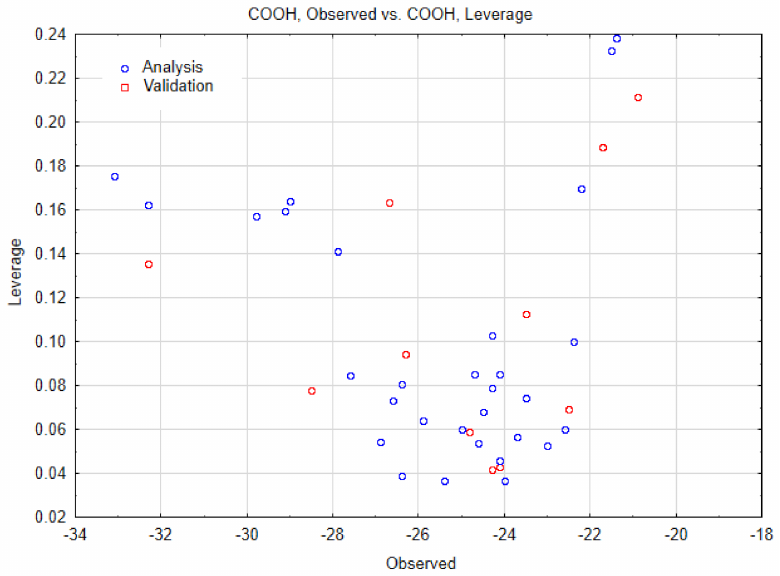
Figure 9. Applicability domain for SWCNT-COOH